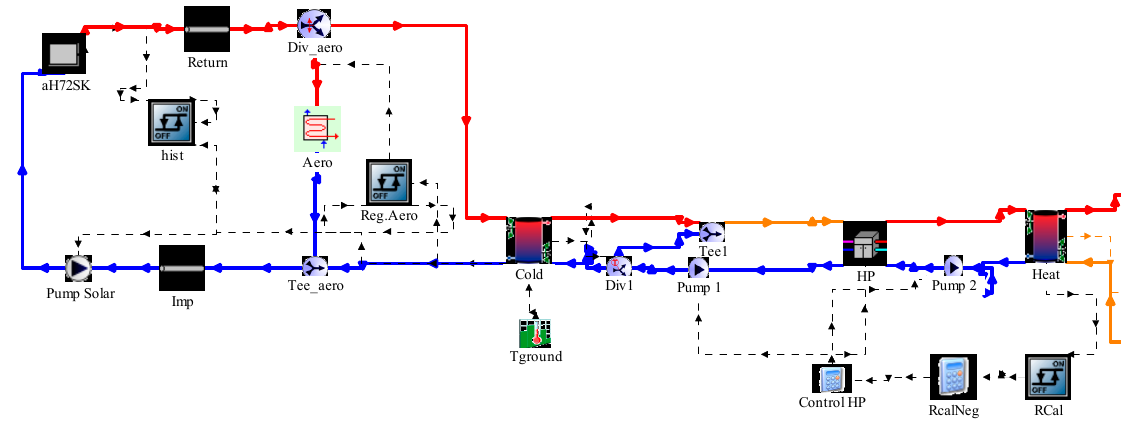
Figure 3. Basic layout of the system in the dynamic simulation software TRNSYS.